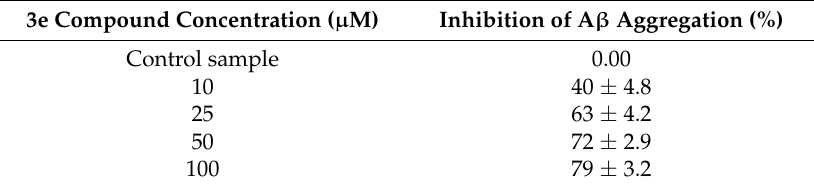
Table 2. Inhibition of A β 1–42 self-aggregation by compound 3e at different concentrations by Thioflavin T assay ( λ exc = 446 nm; λ em = 490